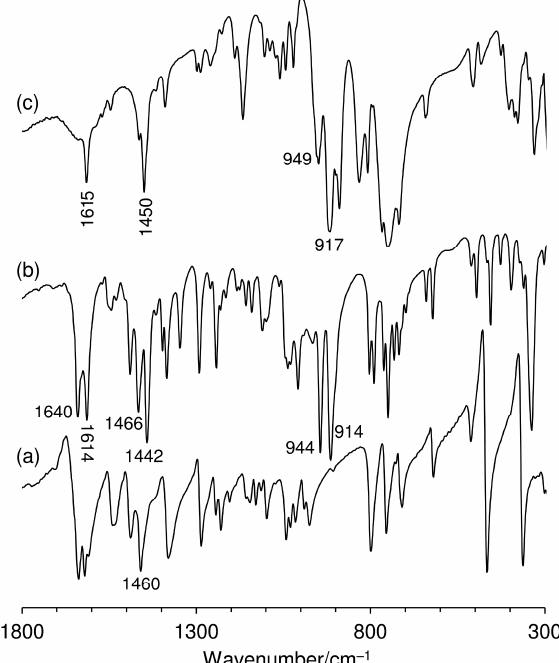
Figure 4. FT ‐ IR spectra in the region 300–1800 cm − 1 of ( a ) Hpytz, ( b ) compound 1 , and ( c ) hybrid 2 .